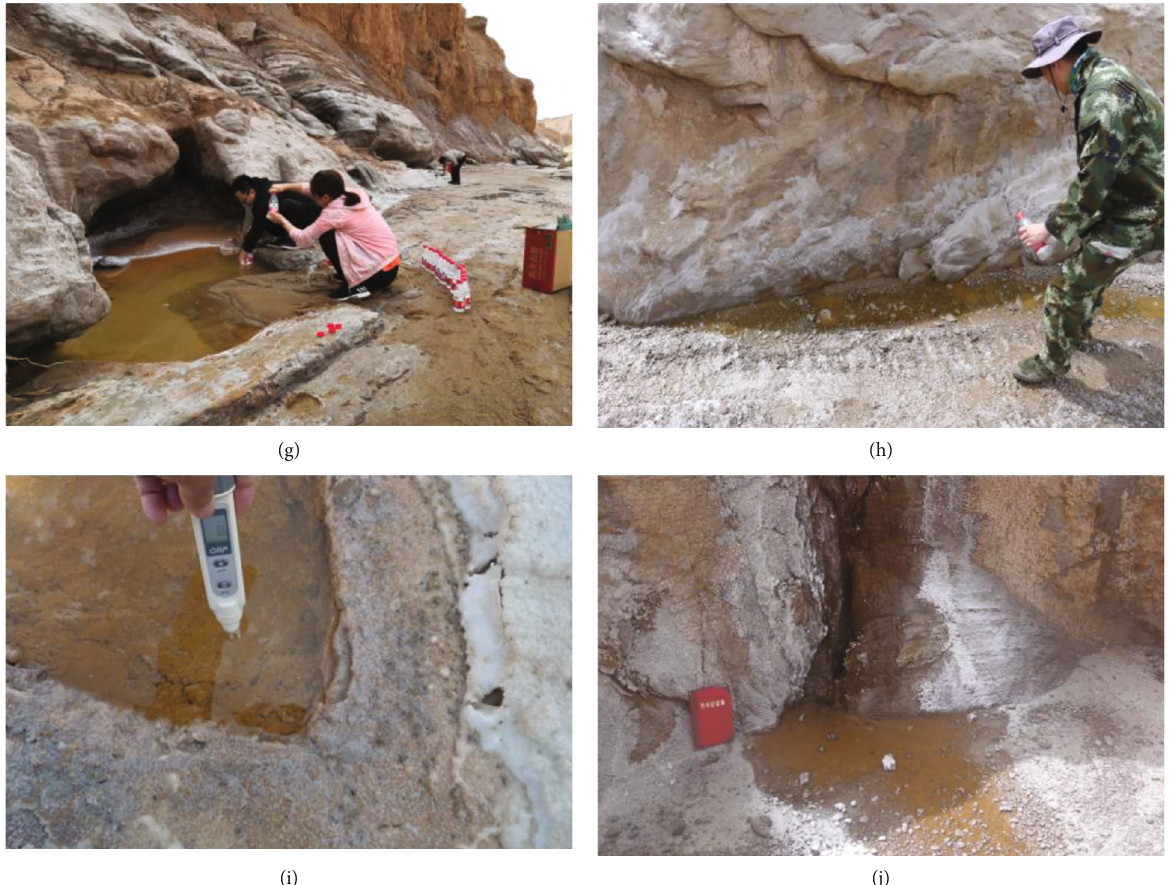
Figure 2: Sampling locations of brine and Cu-mineralized halite (gypsum). (a) Fractured fault belts of sandstone named “ a ” (the Kezier Cu mineralization occurrence); (b) Cu-mineralized halite (gypsum) of a site (sample no. KC-G (the Kezier Cu mineralization occurrence); (d) Cu-mineralized halite (gypsum) of b site (sample no. KC-G halite on the surface of mud located in the scallops of sandstone (sample no. KC-G brine in the Kezier Cu mineralization occurrence; (h) the surface brine in the Dongyanshuigou Cu mineralization occurrence; (i) the surface brine in the Wenbashen Cu mineralization occurrence; (j) the surface brine in the east about 1.5km away of Dongyanshuigou Cu mineralization